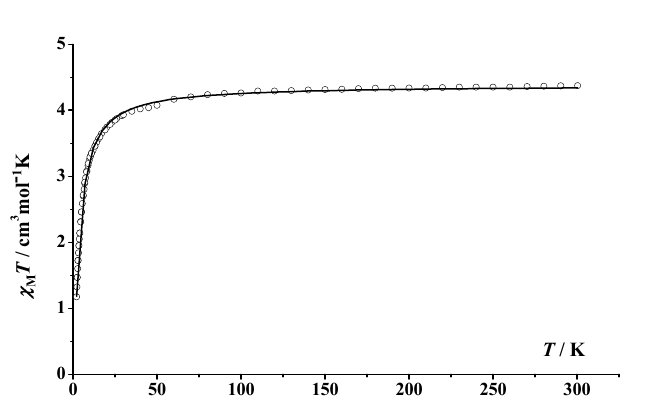
Figure 7. χ M T vs. T Plot for catena -[Mn(µ 1,5 -dca) 2 (4-MOP–NO) 2 ] ( 2 ). The solid line represents the best fit (see text).